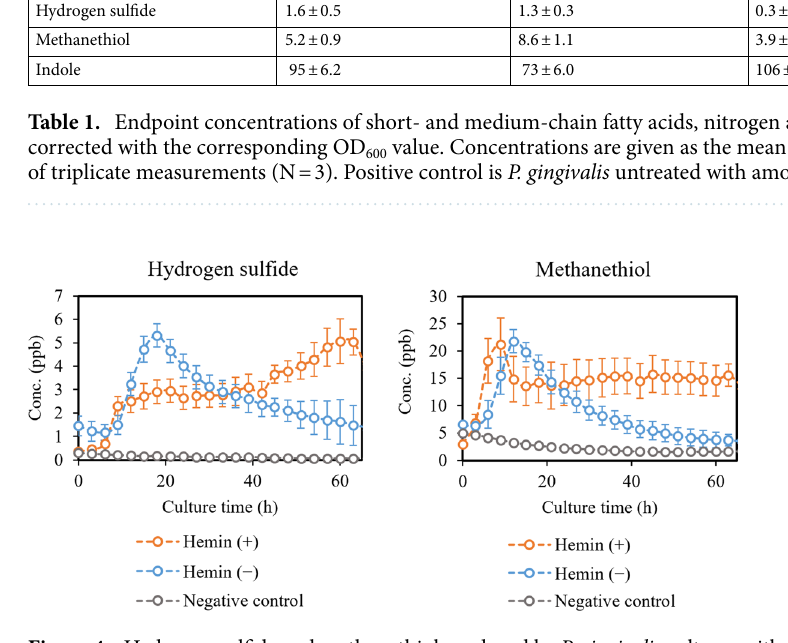
Figure 4. Hydrogen sulfide and methanethiol produced by P. gingivalis cultures with ( +) and without ( −) supplemental hemin added. Concentrations are given as the mean ± SD of triplicate measurements (N =